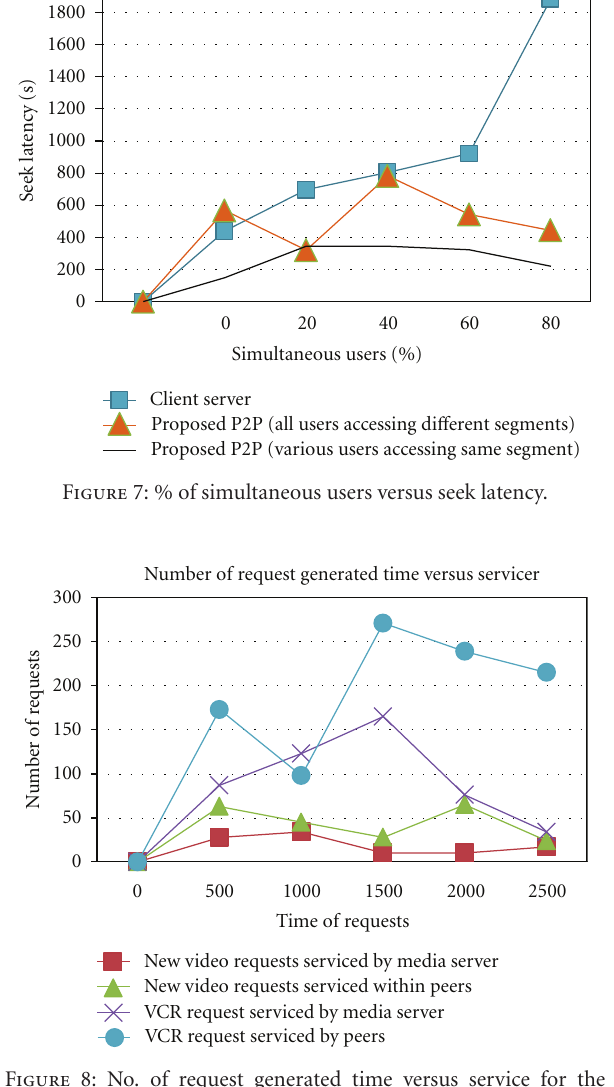
Figure 8: No. of request generated time versus service for the proposed system.